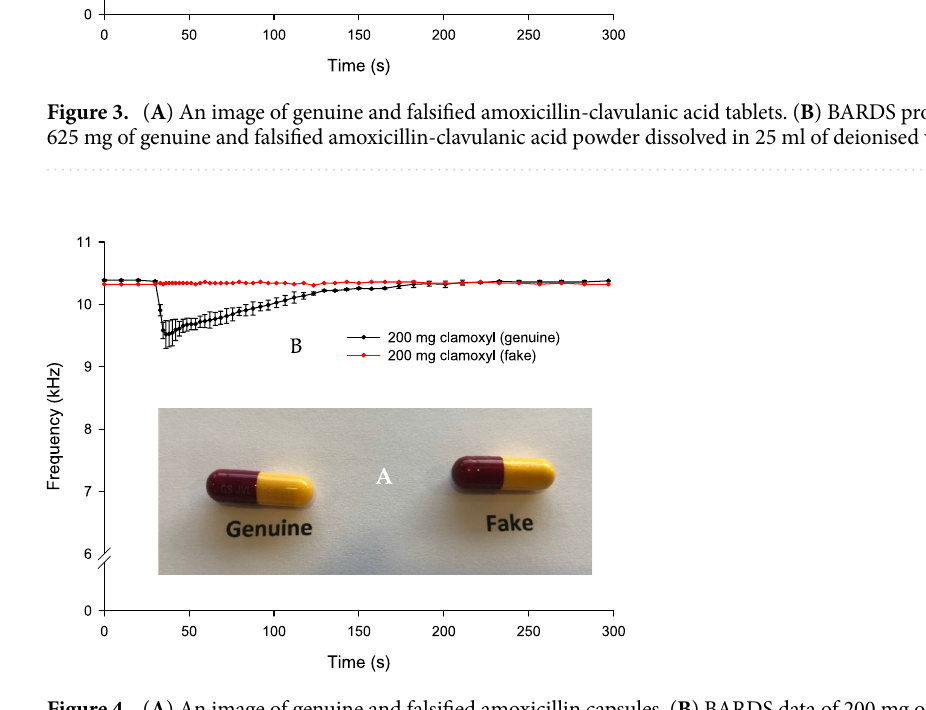
Figure 4. ( A ) An image of genuine and falsified amoxicillin capsules. ( B ) BARDS data of 200 mg of genuine and falsified amoxicillin powder content dissolved in 25 mL of deionised water. Note the falsified data is a single replicate due to the powder being